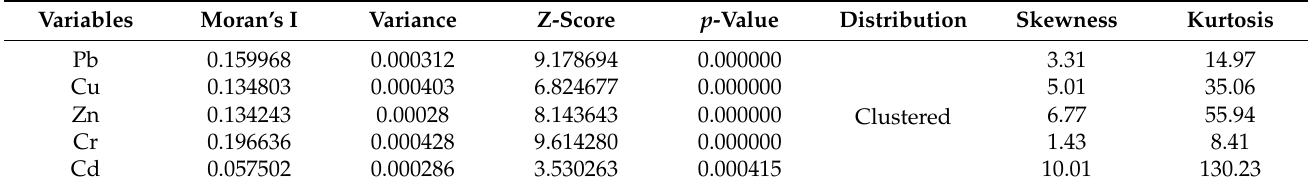
Table 3. Global Moran’s I Summary of statics for an existing data set of PTE in green space areas.